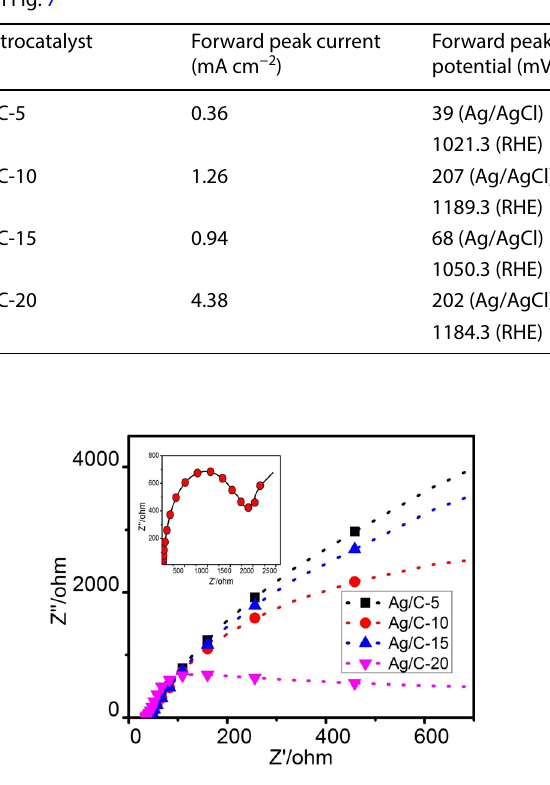
Fig. 8 EIS at 0.5 M NaOH + 0.01 M NaBH fied electrodes. Inset shows the EIS profile of Ag/C-20 up to very low frequency